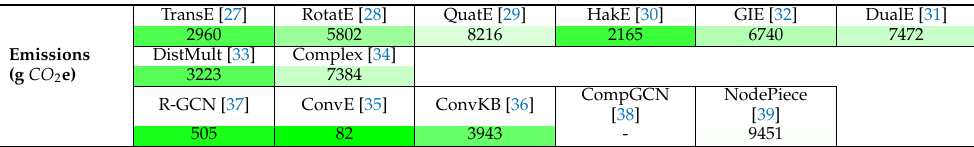
Figure 10. Memory consumption for each model on OGB-BioKG. Red bars denote incomplete experiments due to out-of-memory errors. Table 10. Carbon footprint. The green nature of a model is highlighted with green gradients (the deeper, the